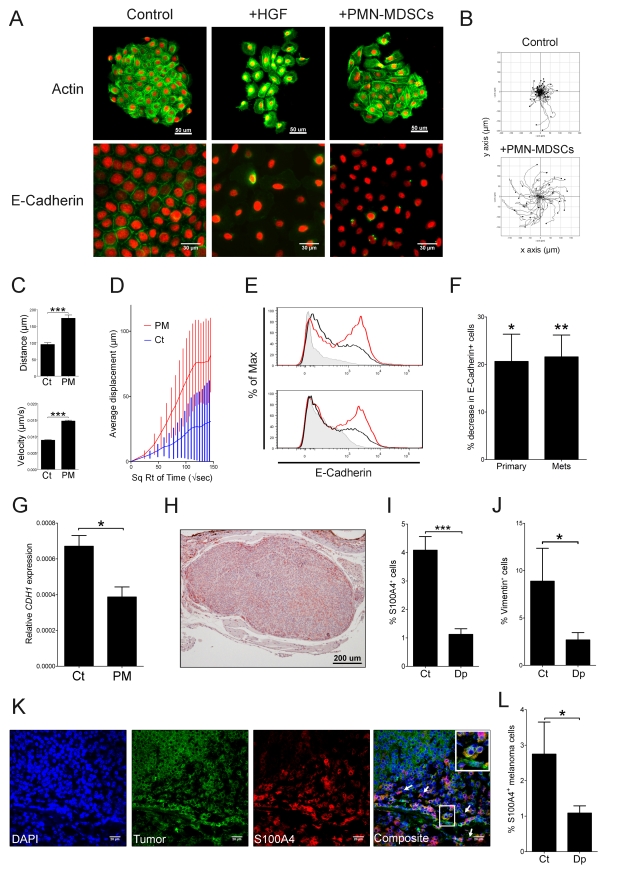
PMN-MDSC induce EMT in vitro and in vivo.(A) PMN-MDSC (1×104 cells per well) were purified from 12-wk-old RETAAD mice and co-cultured with NBT-II cells for 24 h. HGF (5 ng/ml) was added as a positive control for induction of EMT. Green, Actin (upper panel) or E-Cadherin (lower panel); red, H2b (nuclear stain). Images are representative of three independent experiments. (B–D) Individual colonies of NBT-II cells were tracked for 6 h (during hours 12–18) out of the 22 h captured. Tracks of 59 cells from the control and 32 cells co-cultured with PMN-MDSC (1×104 cells per well) were analyzed. Panel B illustrates the individual tracks of all the cells in the colony. Panels C and D show an increase in distance traveled, speed, and displacement of NBT-II cells when co-cultured with PMN-MDSC. PM, PMN-MDSC; Ct, Control. Bars represent mean ± SEM. ***p<0.0001, two-tailed t test. (E) Primary RETAAD tumors (top panel) or cutaneous metastases (bottom panel) were dissociated and co-cultured for 24 h with (black line) or without (red line) PMN-MDSC purified from the same mouse. Data are gated on CD45− live cells. Filled histograms: isotype control. (F) Co-culture for 24 h with PMN-MDSC (as described in Figure 6E) induced a decrease in the number of tumor cells expressing E-Cadherin. Data are from five primary tumors and five cutaneous metastases in three independent experiments. Bars represent the mean decrease in the number of live CD45− E-Cadherin+ cells ± SEM *p<0.05, **p<0.01, two-tailed t test. (G) PMN-MDSC decrease CDH1 gene expression in vitro. Human melanoma cell line, 888mel, was co-cultured with PMN-MDSC purified from a tumor-bearing RETAAD mouse. Cells were washed and harvested after 24 h. Data are from three independent experiments. Bars represent mean ± SEM *p<0.05. (H–I) Staining for S100A4 in primary eye tumor nodules. Panel H is a representative staining of primary tumors for S100A4. Red, S100A4; blue, Heamatoxylin (Nuclear stain). Panel I shows a decrease in the percentage of S100A4+ cells in the tumors depleted from PMN-MDSC (depletion scheme A). Dp, PMN-MDSC depleted mice; Ct, Control mice. Bars represent mean ± SEM of 176 control and 87 PMN-MDSC depleted tumor nodules. ***p<0.0001, two-tailed t test. (J) Decreased percentage of vimentin+ cells in tumors depleted from PMN-MDSC (depletion scheme A). Dp, PMN-MDSC depleted mice; Ct, Control mice. Bars represent mean ± SEM of 14 pairs of primary tumors. *p<0.05, two-tailed paired t test. (K) The majority of S100A4+ cells express melanoma specific antigens. Eye tumors were co-stained for melanoma antigens (HMB45 and MelanA/MART-1) and S100A4. White arrows indicate S100A4+ melanoma cells exhibiting a fusiform morphology. Note the different morphologies of the double-stained mesenchymal-like cells and single-stained ones. Blue, DAPI (nucleus); green, HMB45/DT101/BC199 (melanoma); red, S100A4. (L) Decreased percentage of S100A4+ melanoma cells in tumors depleted from PMN-MDSC (depletion scheme A). Double positive cells stained for HMB45/MART-1 and S100A4 were quantified from three depleted (Dp) and three control (Ct) mice.